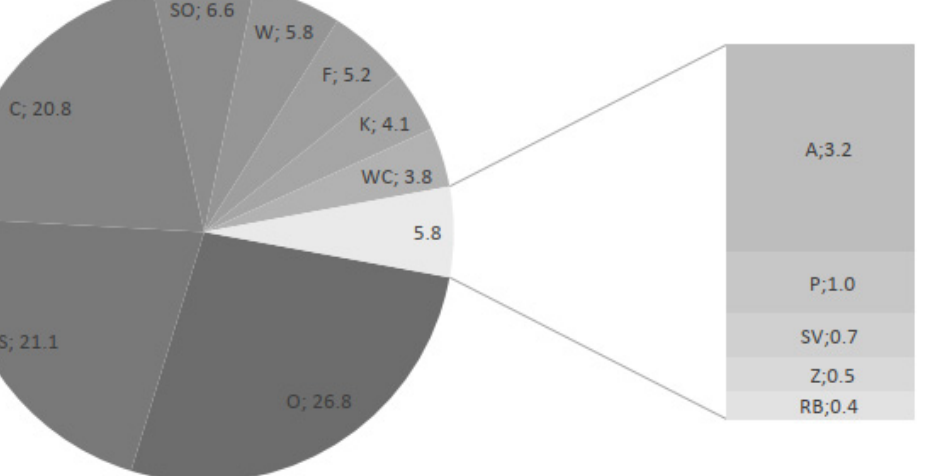
Figure 2. Average percentages of the different land uses in the 1500 m radius areas around the sam- pled olive groves. olive grove (O), field crop (C), scrubland (S), scrubland with oaks (SO), woody crop (W), artificial (A), pastures (P), oak forest (K), sparse vegetation (SV), pine forest (F), riverside vegetation (RB), landscape mosaic (Z) and watered crop (WC).